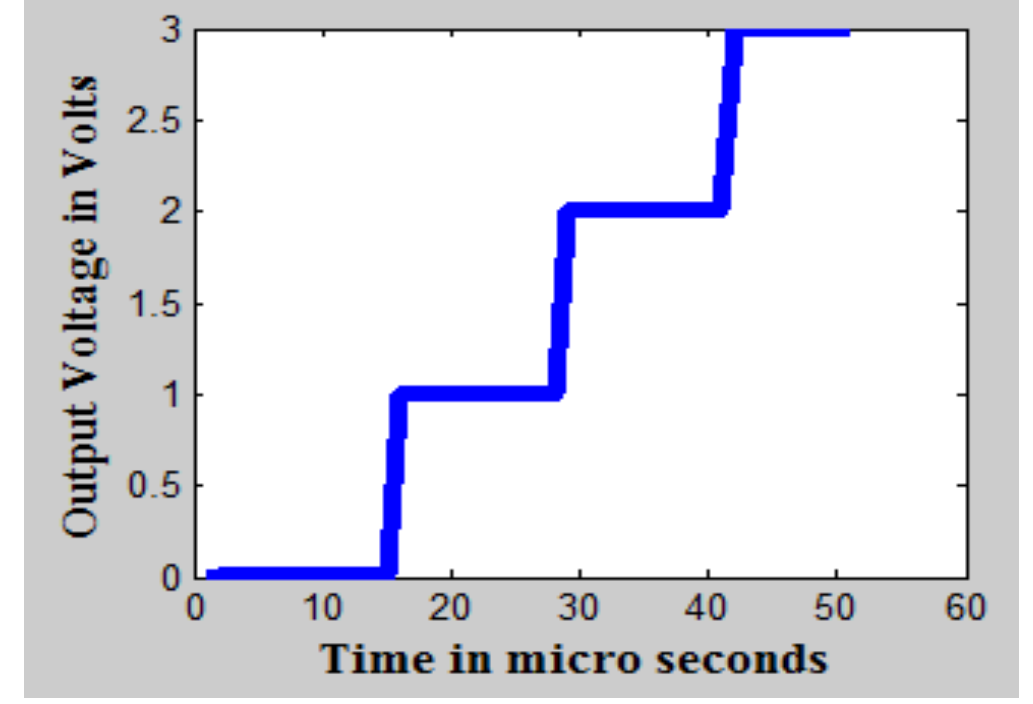
Figure 16. Maximized view of output voltage for 50 microseconds.